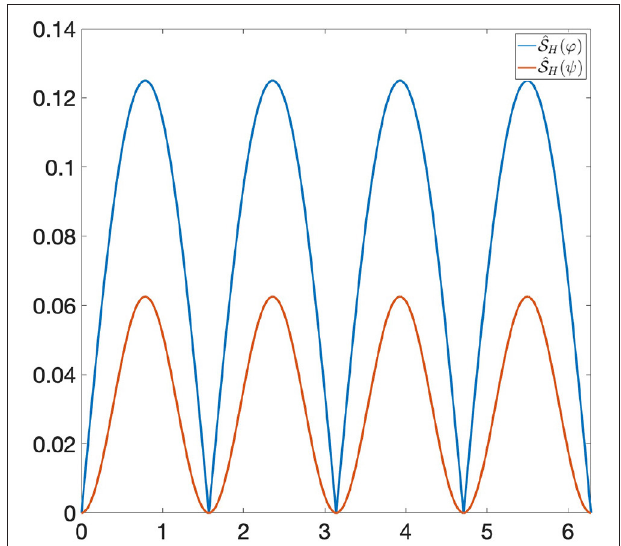
FIGURE 2 | F 1 ( ϕ ) and F 1 ( ψ ) have the same persistence diagram.